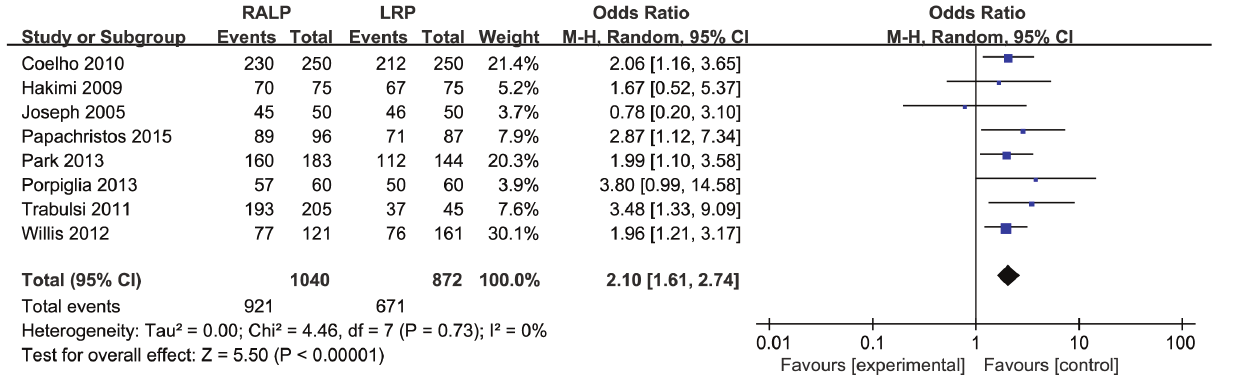
Figure 4: The forest plot for the postoperative urinary continence rate 1 year after RALP and